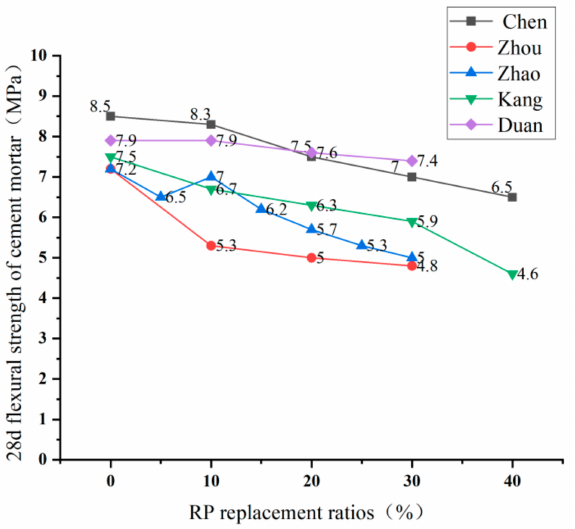
Figure 15. Flexural strength of cement mortar under different replacement ratios of RP